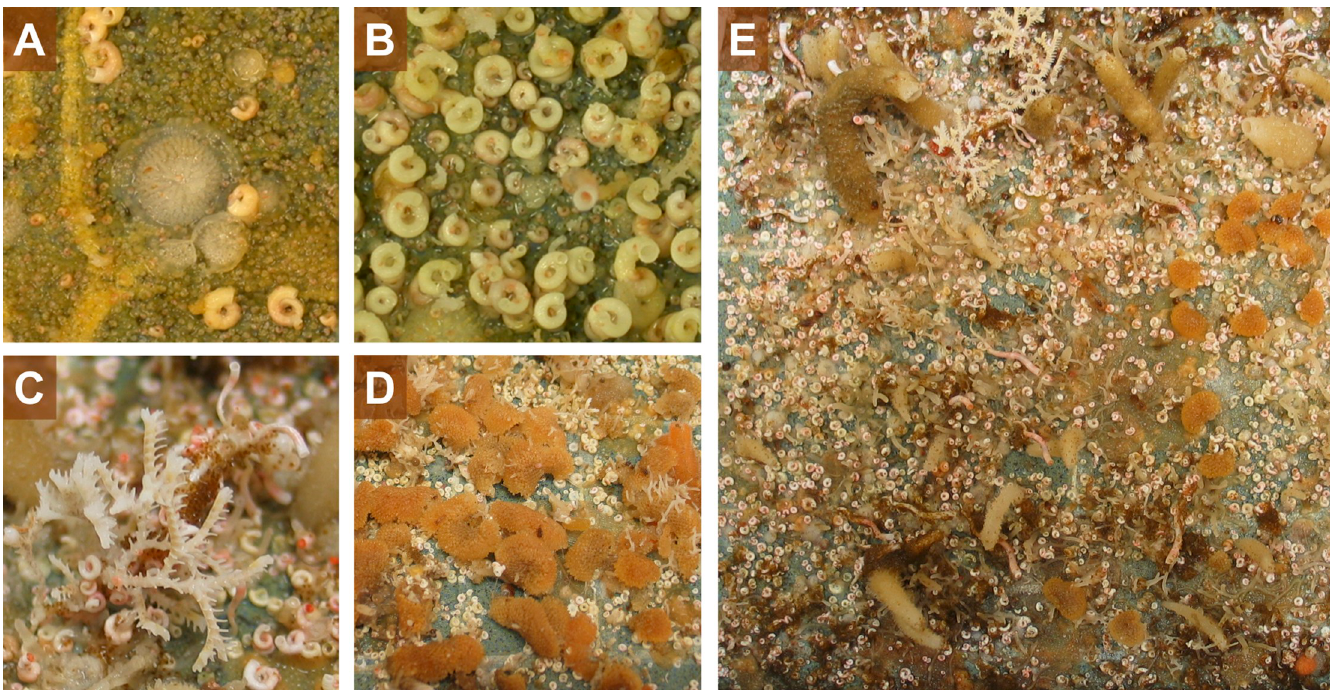
Fig 3. Images of the tiles recovered after 6 (A-B) and 9 (C-E) years. A) A cyclostome colony of Disporella sp.; B) Spirorbid species which form closely coiled tubes (referred here as Spirorbis sp.1); C) a cyclostome colony of Idmidronea sp. and the spirorbid species which form tusk-shaped tubes (top right; Spirorbis sp. 2); D) colonies of the cheilostome Beania erecta . E) entire tile colonized by bryozoan colonies, spirorbid polychaetes and different species of sponges.